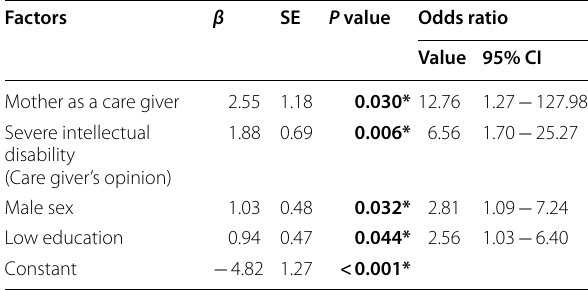
Bold indicates the level of significance was taken at P value <